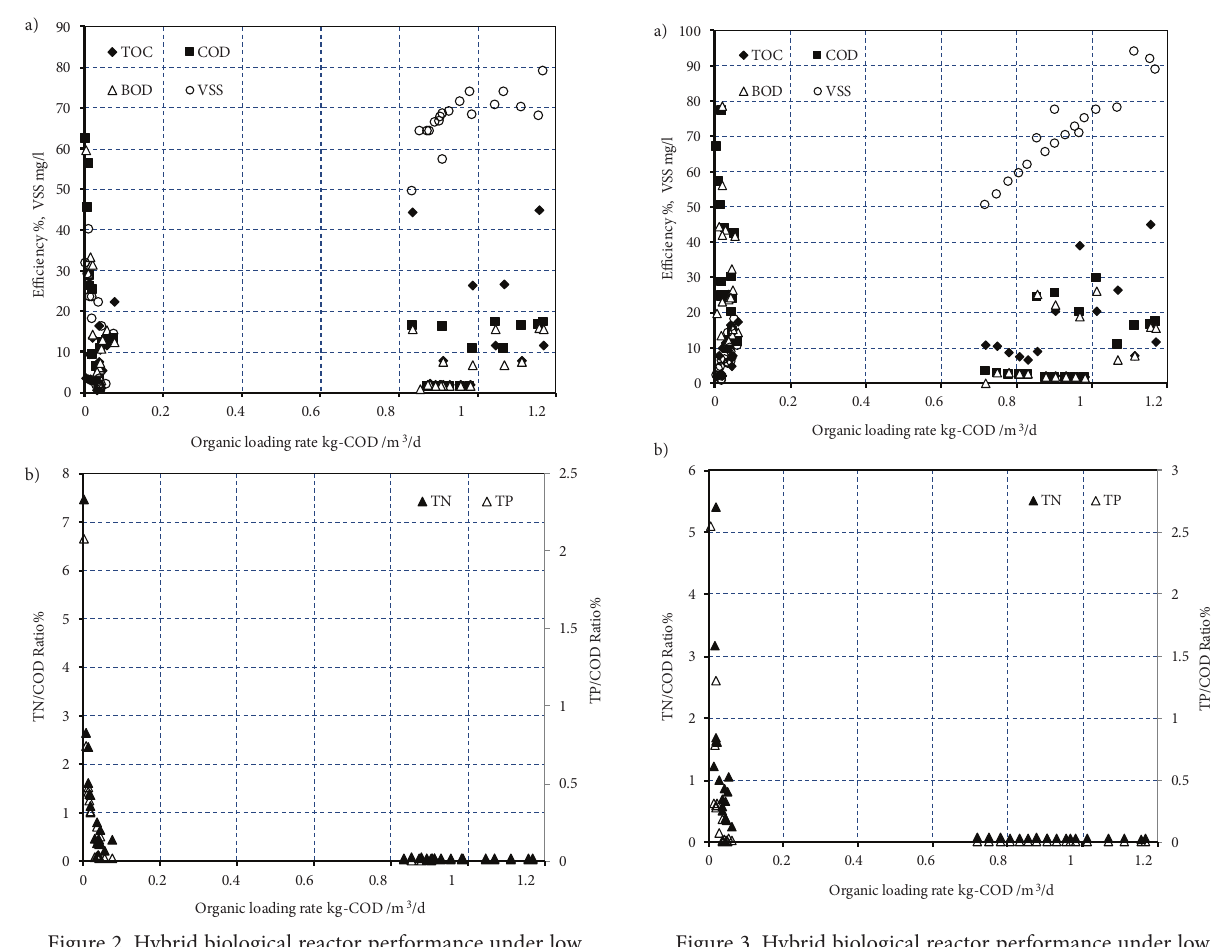
Figure 2. Hybrid biological reactor performance under low flow-low oxygen scenario: a) organics removal efficiency and VSS concentration versus organic loading rate; b) TN/COD, TP/COD, versus organic loading rate